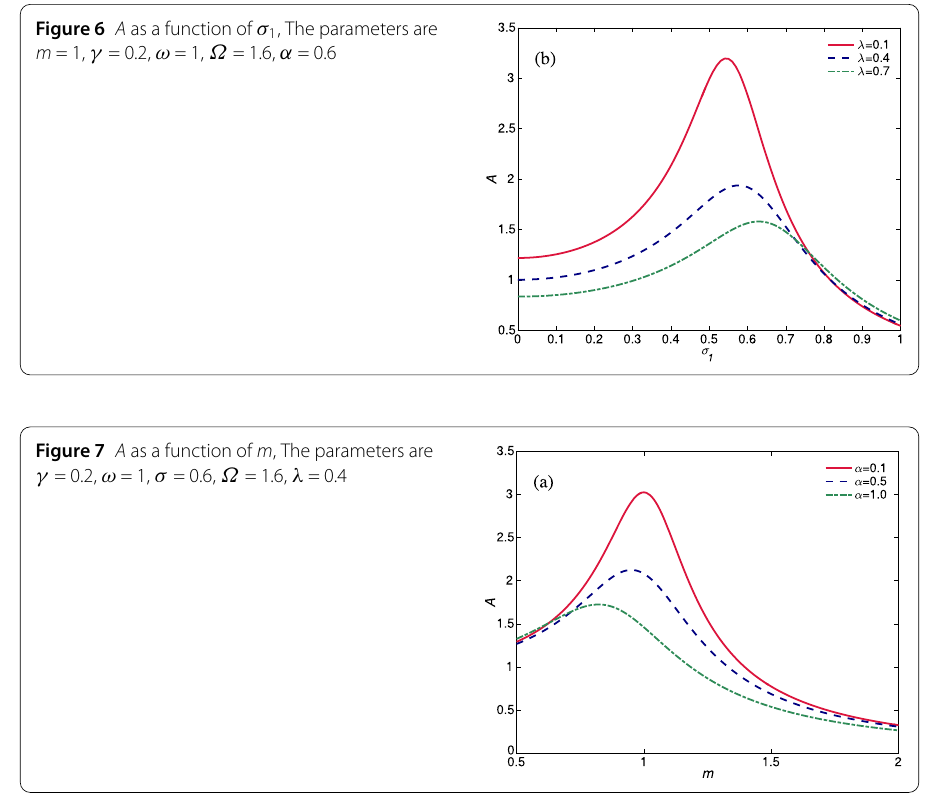
Figure 7 A as a function of m , The parameters are γ = 0.2, ω = 1, σ = 0.6, Ω = 1.6, λ =